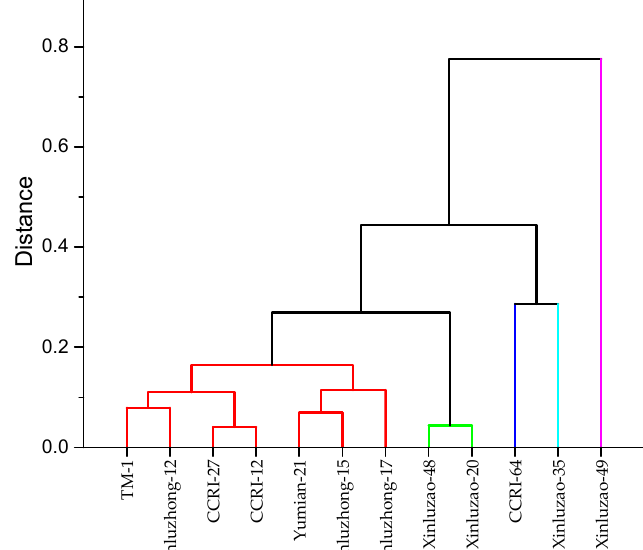
Figure 3. Dendrogram hierarchical cluster analysis of cotton genotypes based on morphophysiological traits grown under various P concentrations (0, 10, 20, 40, 80, and 500 μ M).